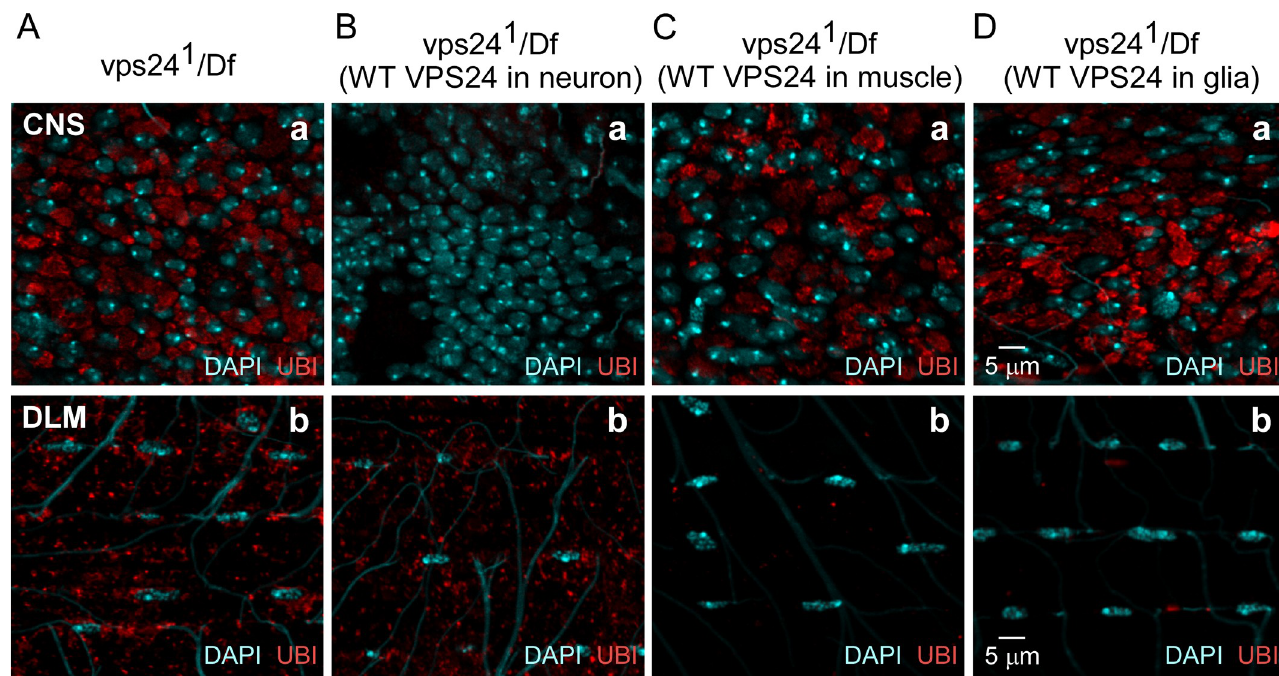
Fig 4. Cell-autonomous rescue and -nonautonomous suppression of ubiquitin-positive compartment accumulation in the vps24 mutant. Confocal immunofluorescence images of CNS neurons (a) and DLM (b) of the vps24 mutant (A) , or the mutant rescued by neuronal (B) , muscle (C) or glial (D) expression of the wild-type EGFP-VPS24 protein. Neuronal or muscle expression of wild-type EGFP-VPS24 produces cell-autonomous rescue of the vps24 mutant phenotype in the respective cell type. Notably, glial expression of wild-type VPS24 produces cell-nonautonomous suppression of the vps24 phenotype in muscle but not